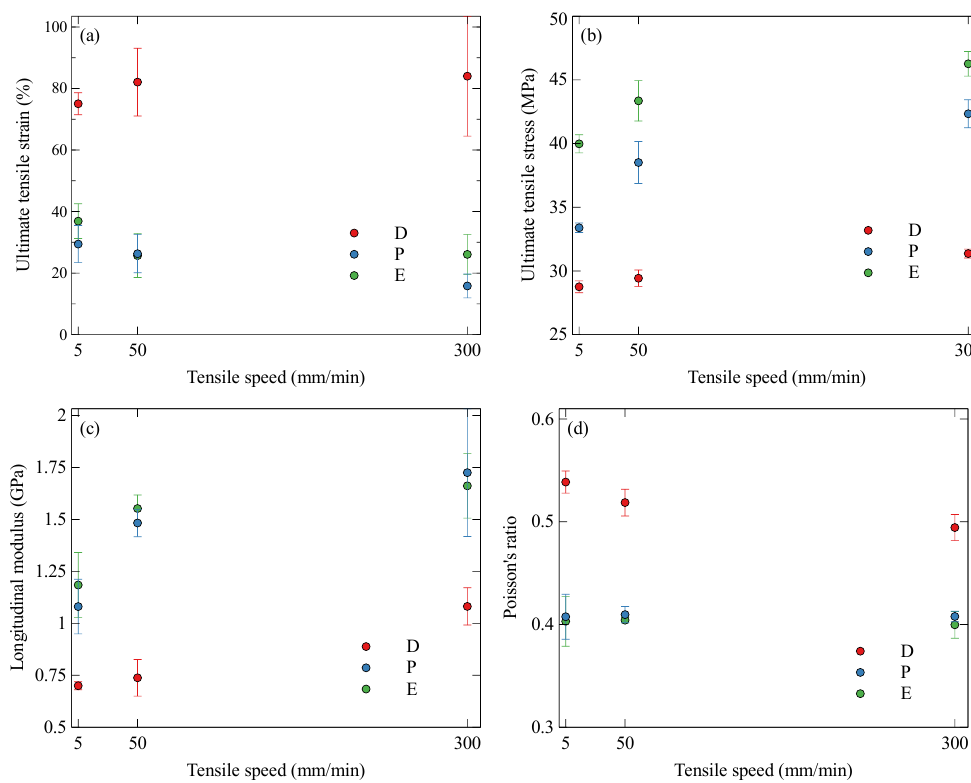
Figure 5. Variation of tensile properties of Onyx with strain rate and orientation: ( a ) ultimate tensile strain, ( b ) ultimate tensile stress, ( c ) longitudinal modulus, and ( d ) Poisson’s ratio for default (D), parallel (P) and on-edge (E)